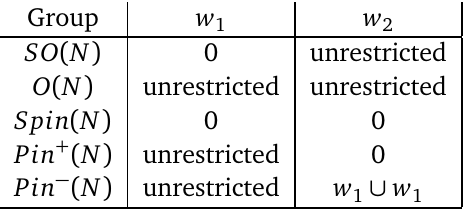
Table 1: Allowed bundle topology for various gauge